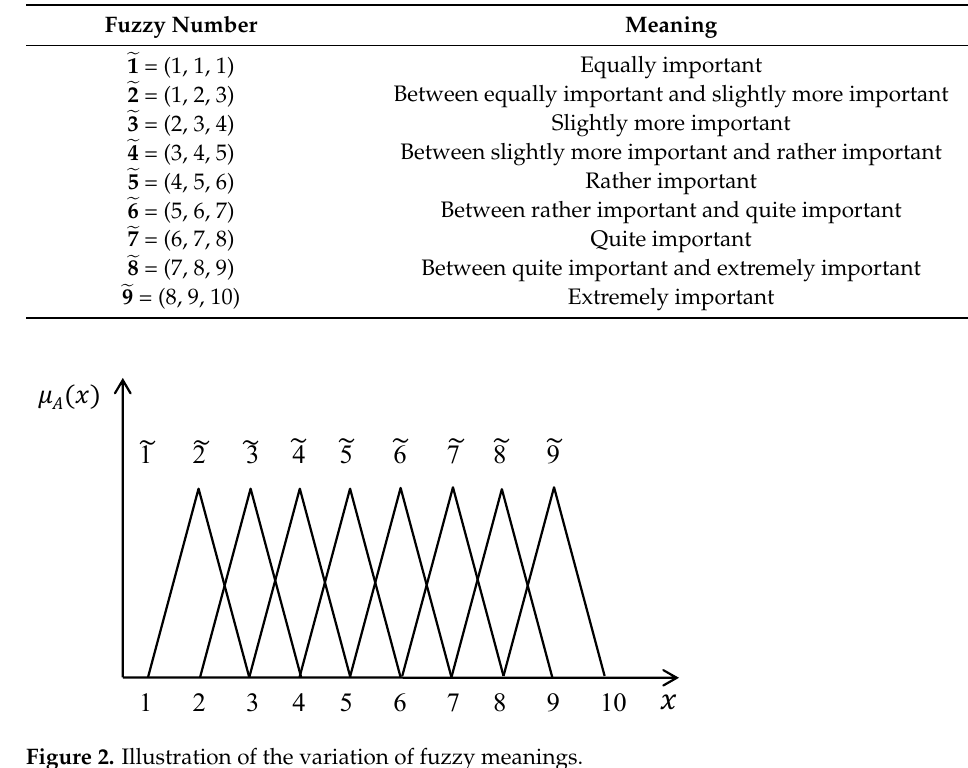
Figure 2. Illustration of the variation of fuzzy meanings.